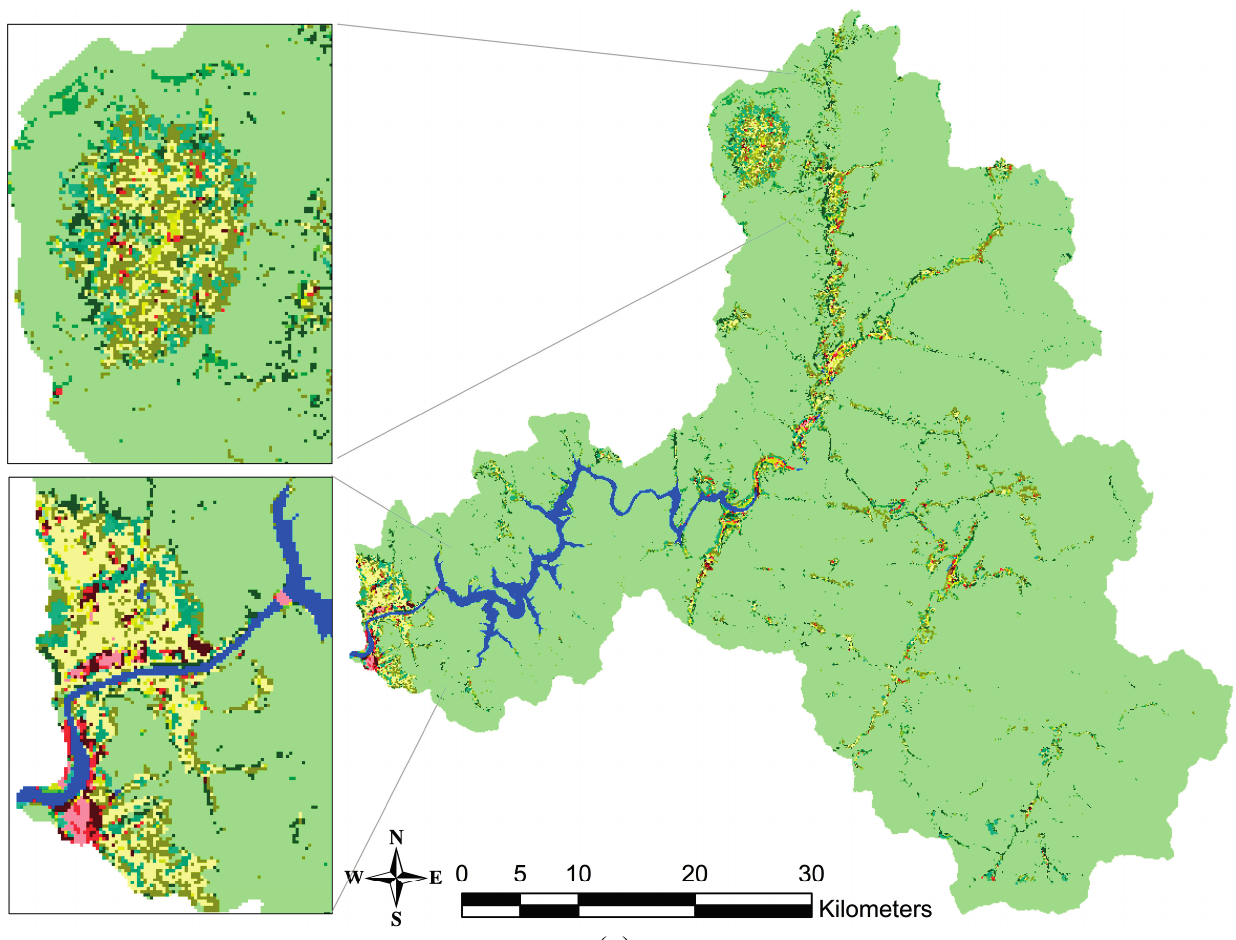
Figure 4. Temporal land-use changes between 1980-1990 (a) and 1990-2000 (b) in the So-yang River